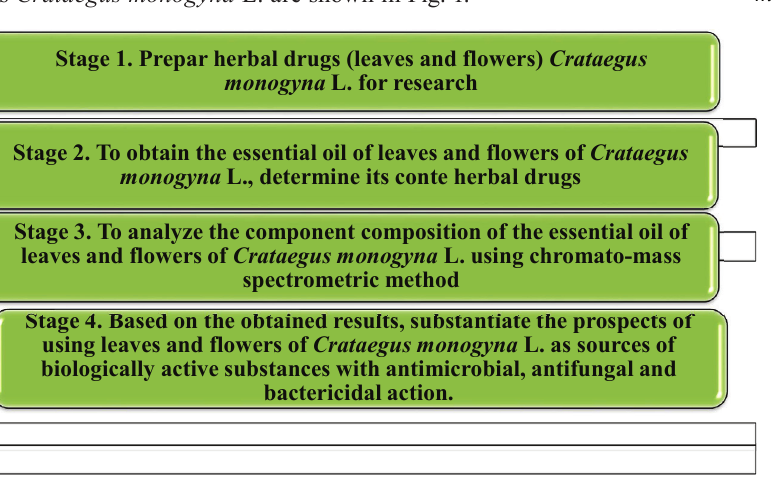
Fig. 1. The stages of the research of the component composition of the essential oil of leaves and flowers of Crataegus monogyna L.